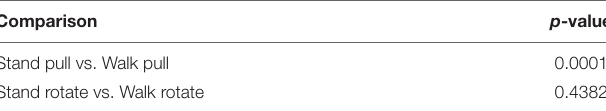
Frontiers in Human Neuroscience |